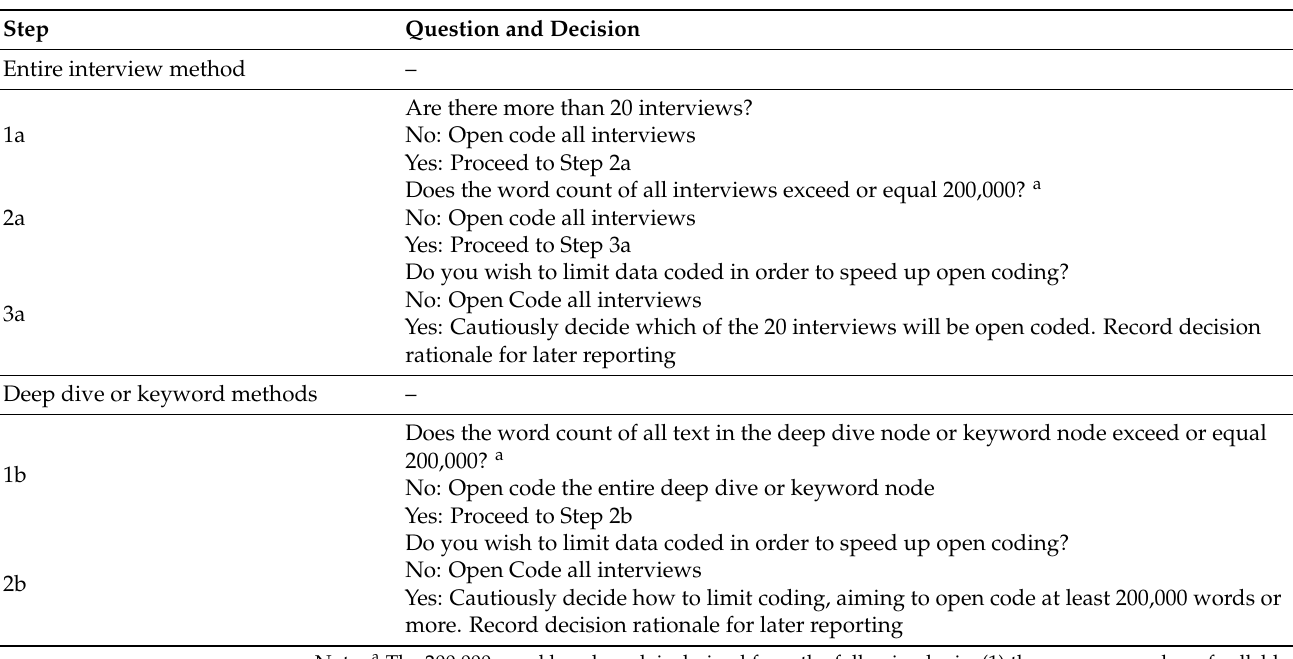
Table 1. Decisions around limiting the amount of data open